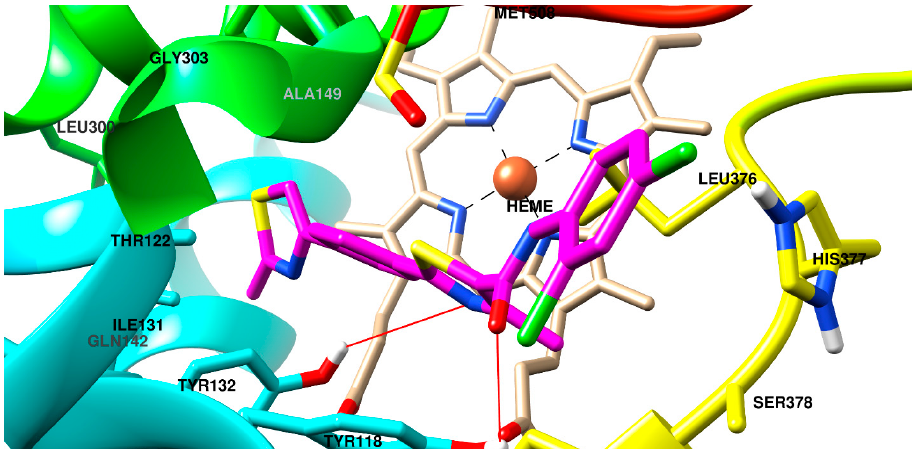
Figure 4. Docking pose of the compound 5h in the binding site of lanosterol 14 α -demethylase